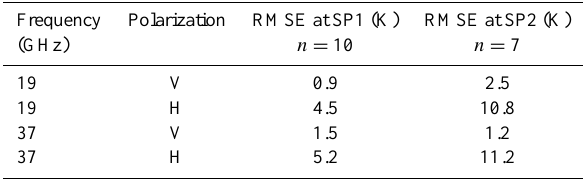
Figure 7. Measured and modeled brightness temperature as a func- tion of the incidence angle for two locations at 37GHz and vertical polarization. Observations and simulations (solid lines) in Fig. 6 are repeated using the same symbols. In addition, simulations with mixed profiles are shown in purple (density from SP1 and SSA from SP2) and cyan (density from SP2 and SSA from SP2). Table 2. Root mean square error between the modeling results and radiometric measurements at SP1 and